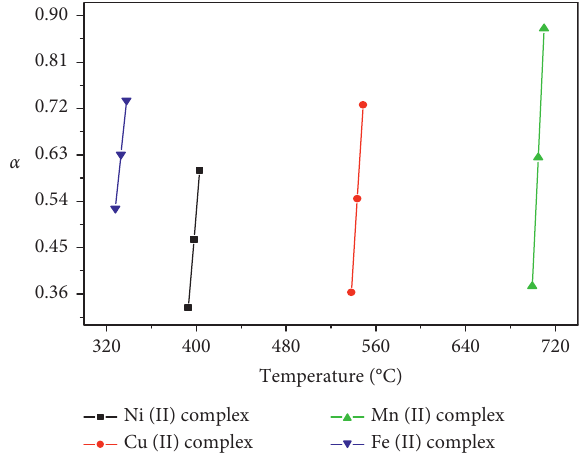
Figure 8: Fraction decomposed ( α ) and temperature plots ( T ) of the complexes. Table 4: Kinetic parameters for the thermal decomposition of Ni(II) and Cu(II) complexes using nonmechanistic equations in dynamic air by Coats–Redfern equation.